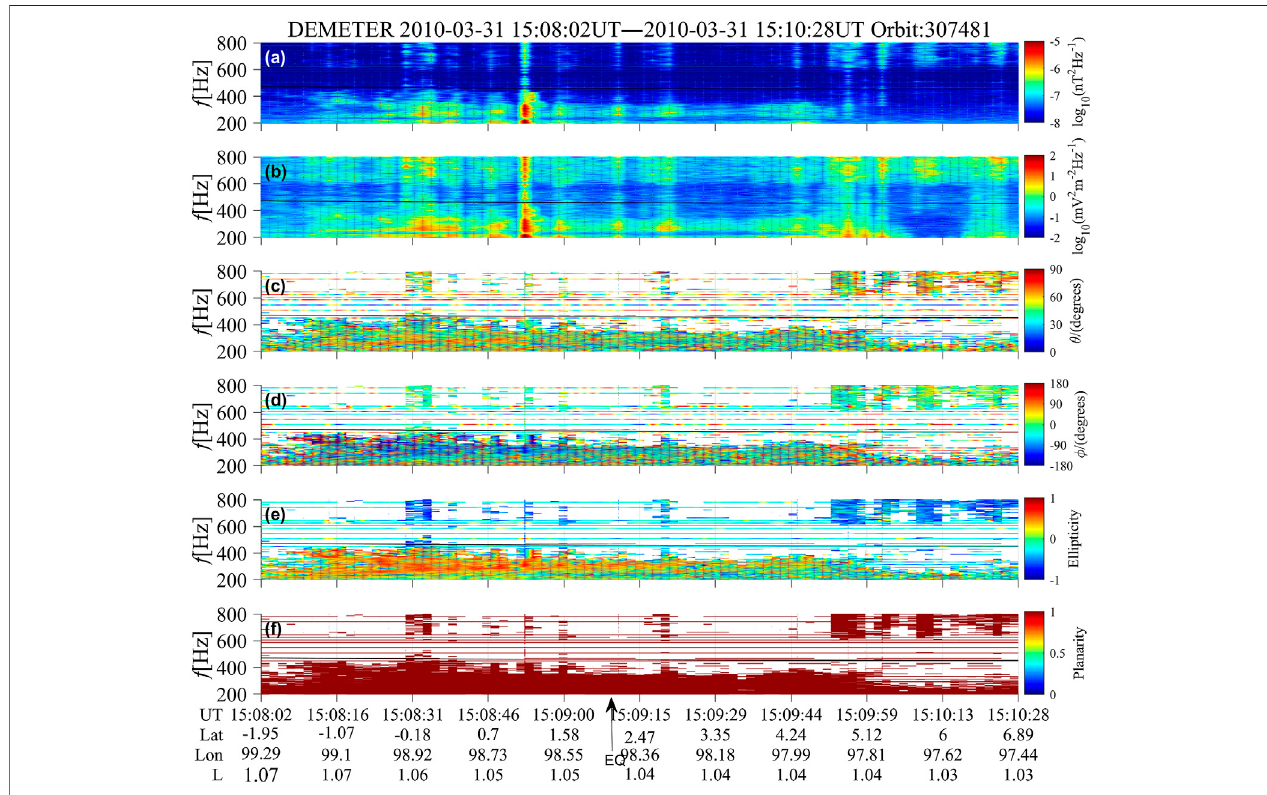
FIGURE9| ThewavepropagationparametersofextremelylowfrequencywavesrecordedbyorbitNo.307481at15:08to15:10 UTonMarch31,2010.Fromtop to bottom: (A,B) the power spectral values of magnetic fi eld and electric fi eld, (C) the wave normal angle θ ; (D) the azimuthal angles ϕ ; (E) the ellipticity, (F) planarity.